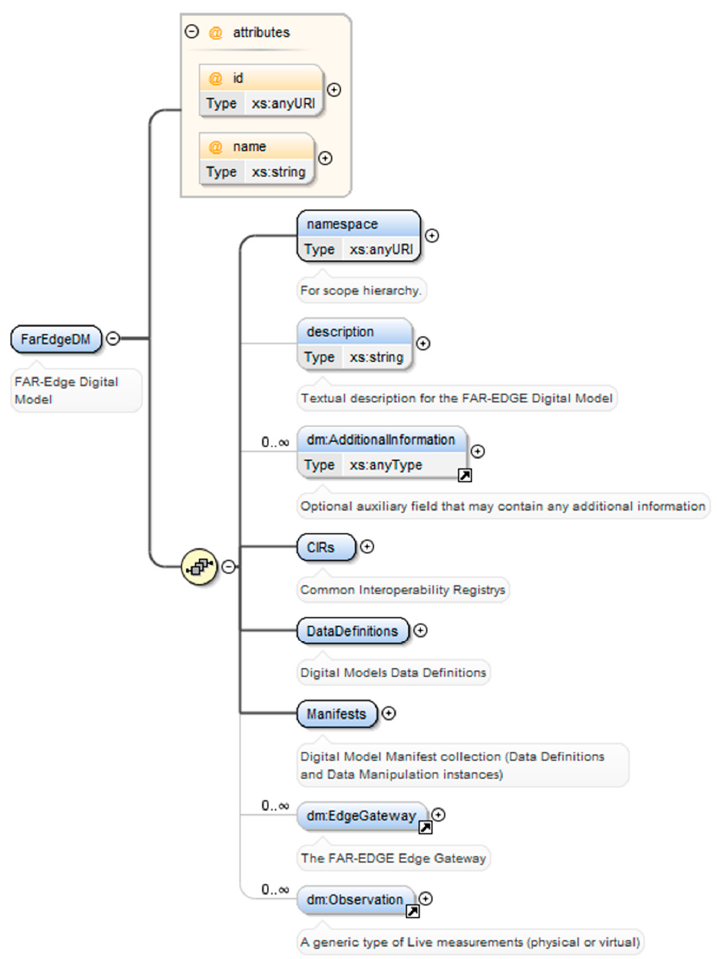
Figure 4. Root of the FAR-EDGE Data Models.